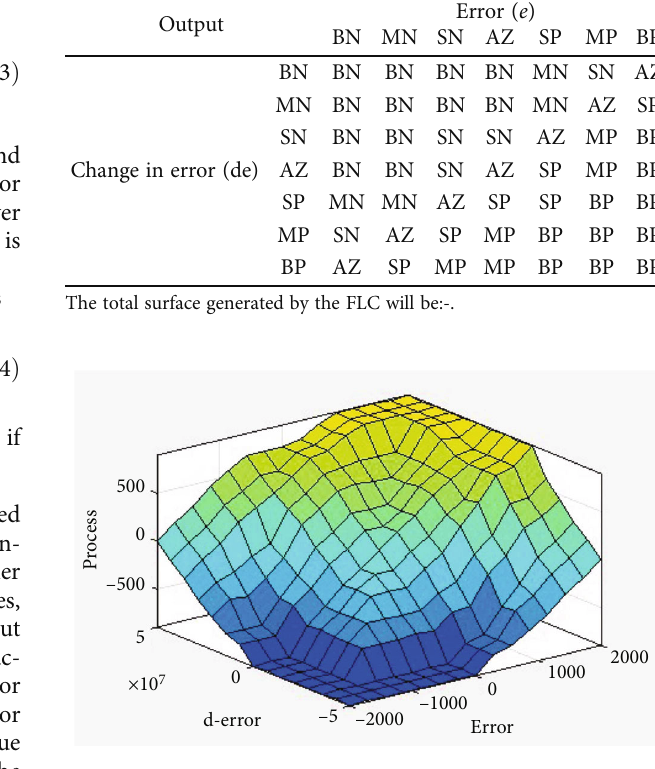
Figure 7: Surface view of